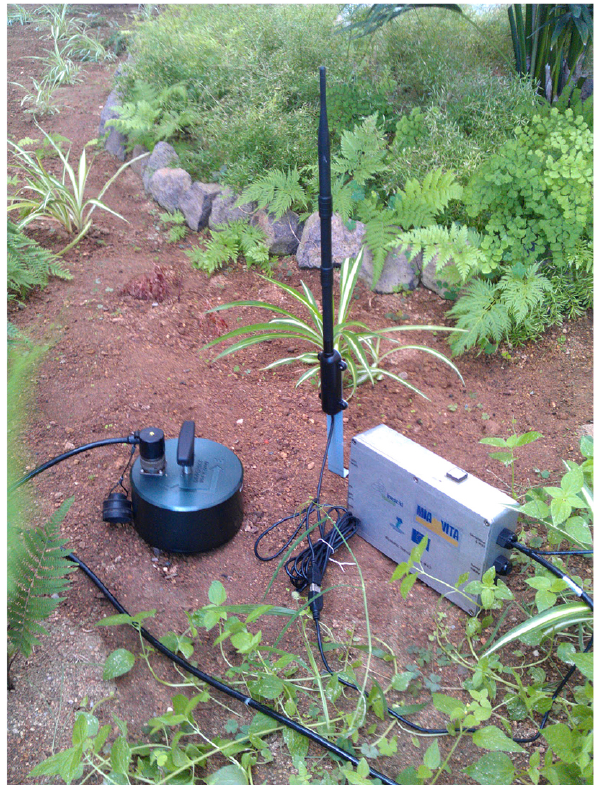
Figure 12. Node deployed in the terrain with wireless antenna in- stalled on the ground and a geophone